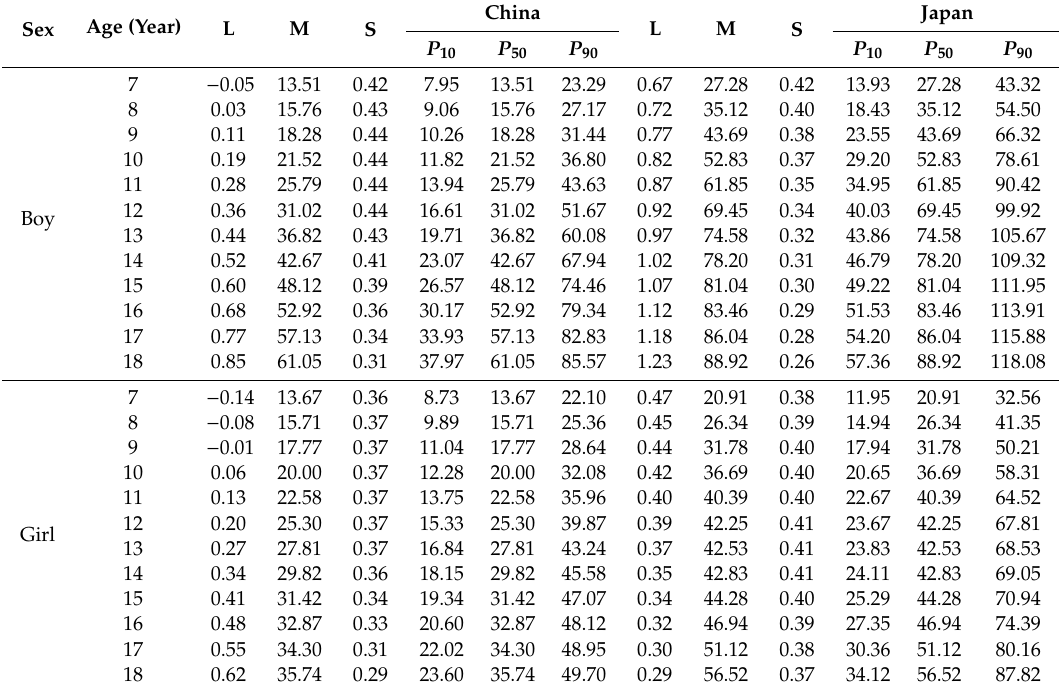
Table 4. The 20-metre shuttle run (number of laps) centiles by age and sex in Chinese and Japanese children and adolescents aged 7–18 years.